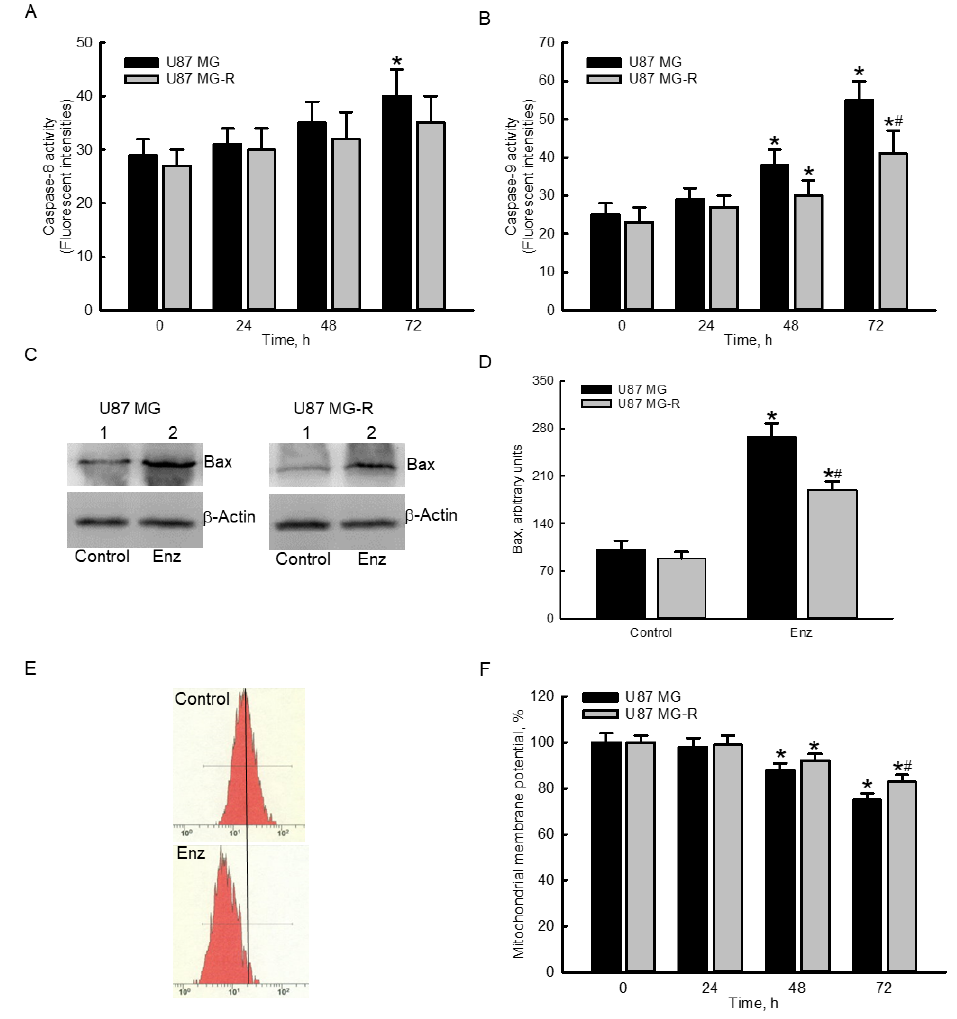
Figure 4. Enzalutamide (Enz) specifically activated caspase-9, increased cellular Bax levels, and decreased the mitochondrial membrane potential in human temozolomide (TMZ)-sensitive U87 MG and TMZ-resistant U87 MG-R glioblastoma cells. Human U87 MG and U87 MG-R glioblastoma cells were treated with 50 µ M Enz for 24, 48, and 72 h. Activities of capase-8 ( A ) and -9 ( B ) were assayed using fluorogenic substrate methods. Levels of the proapoptotic Bax in human U87 MG and U87 MG-R glioblastoma cells were immunodetected (( C ), top panels). β -Actin was analyzed as the internal control (bottom panels). These protein bands were quantified and statistically analyzed ( D ). The mitochondrial membrane potentials of human U87 MG and U87- MG-R cells were measured using flow cytometry ( E , F ). Representative histograms of FACS analyses in human U87 MG cells are shown ( E ). Each value represents the mean ± SEM for n = 6. The symbols * and # respectively indicate that the values significantly ( p < 0.05) differed from the control and U87 MG